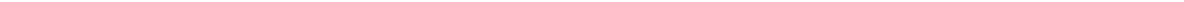
Figure 4 | Ex vivo analysis of drebrin loss of function. ( a ) Cerebella from P7 mice were electroporated, and slices grown in ex vivo culture for 48h. CGNs were electroporated with a vector encoding H2B-mCherry either alone or in combination with the indicated expression vectors. EB1M and EB3M expression was driven in GNPs using pMath1 and in CGNs using pNeuroD. Each representative image is oriented with the cerebellar slice surface to the left, and the presence of red nuclei in the centre or right of the image indicates cells that have left the GZ. The histograms below each representative image show the binned migration distance distribution for each condition ( n Z 2,500 cells analysed for each condition, w 2 test P value o 0.01 between each condition and its control), and the graph to the right shows the average migration distances ( P o 0.05 for all conditions by Student’s t -test). The migration distance graph for each micrograph is scaled to its accompanying image, thus providing the equivalent of a scale bar. ( b ) Live imaging of ex vivo pNeuroD EB1M and EB3M slices confirms migration defects. Representative images in which the cerebellar surface is oriented at the top show the position of H2B-mCherry- labelled nuclei at 2-h intervals. Coloured arrowheads show the relative positions of cells in each frame, and the insets illustrate morphology of cells under each condition. ( c ) Angle analysis of cells tracked in live-cell imaging experiments ( n 4 69 cells for each condition). FDVs were calculated and compared with IDVs for each time. Polar plots representing efficiency show that EB1M-expressing cells had more efficient movements corresponding to their FDV than did EB3M-expressing cells. ( d ) The mean squared displacement (MSD), a Brownian motion measure, was also calculated for each time point of the imaging sequences. The population of EB3M cell movements has more low MSD values, indicating random motion in these cells. ( e ) Radial histogram of the tangential and radial migration angles. Tangential angles are parallel to the 0 (cid:2) to 180 (cid:2) axis (that is, parallel to the slice surface), whereas radial angles are oriented towards 90 (cid:2) (that is, perpendicular to the slice surface). Scale bar, 10 m m. Error bars show ±